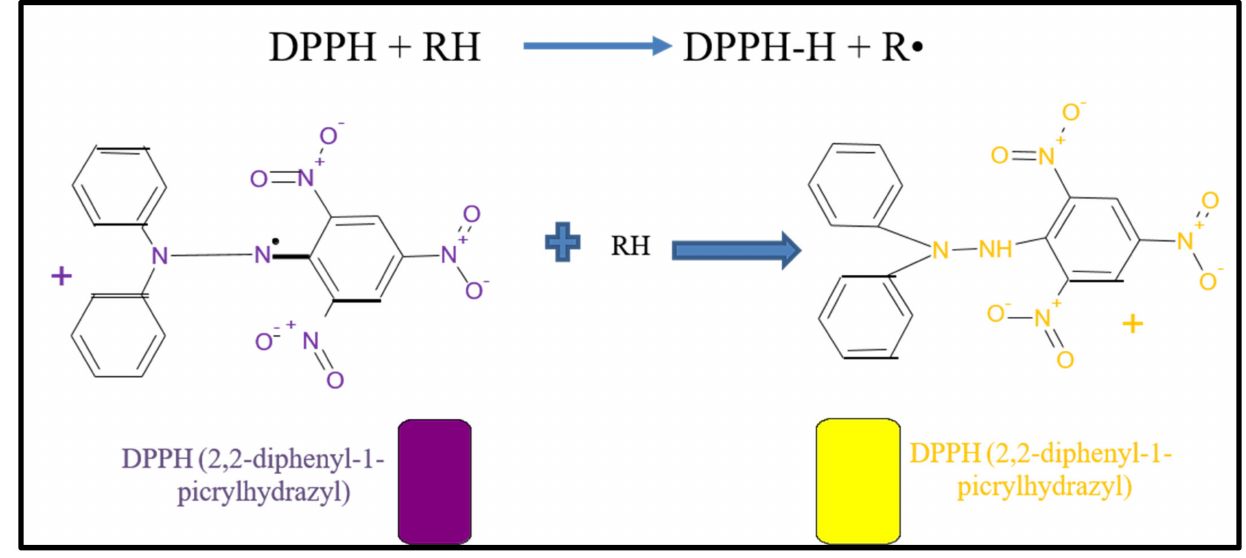
Figure 2. Mechanism of antioxidant activity.